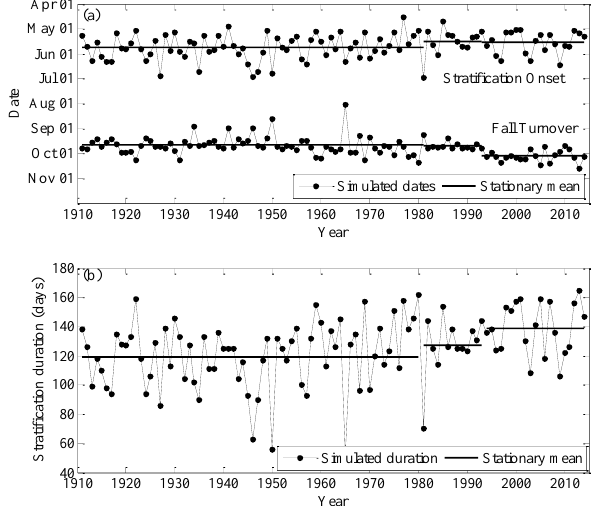
Figure 11. (a) Simulated date of stratification onset and fall turnover and (b) stratification duration. Stationary means for three selected periods are denoted by solid